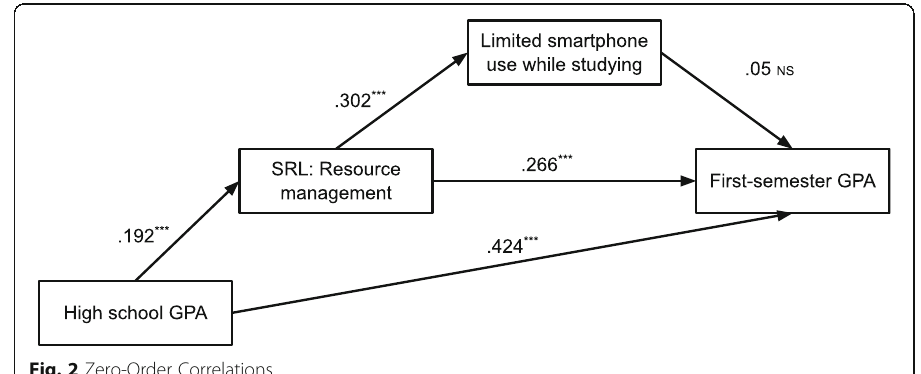
Fig. 2 Zero-Order